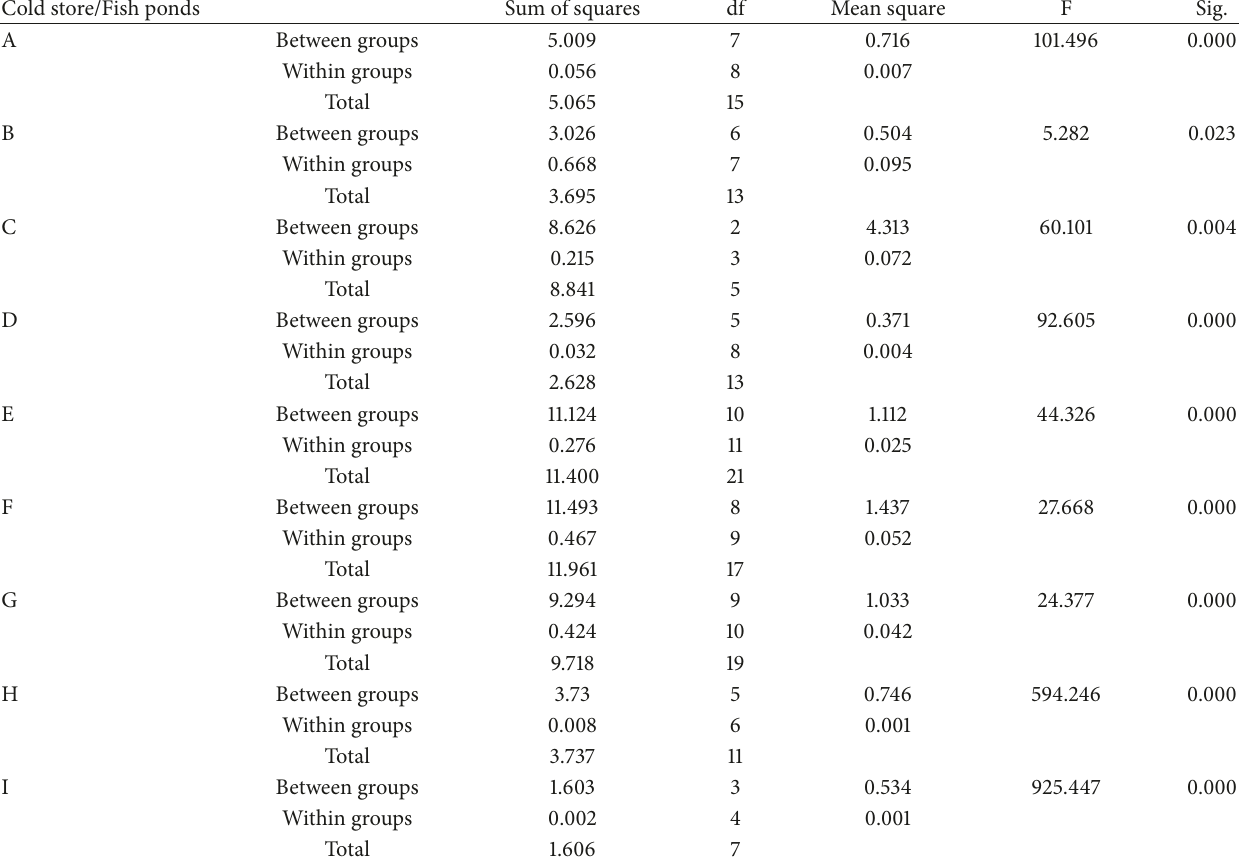
Table 4: One-way ANOVA results for the fish species from the various cold stores/fish ponds. Cold store/Fish ponds